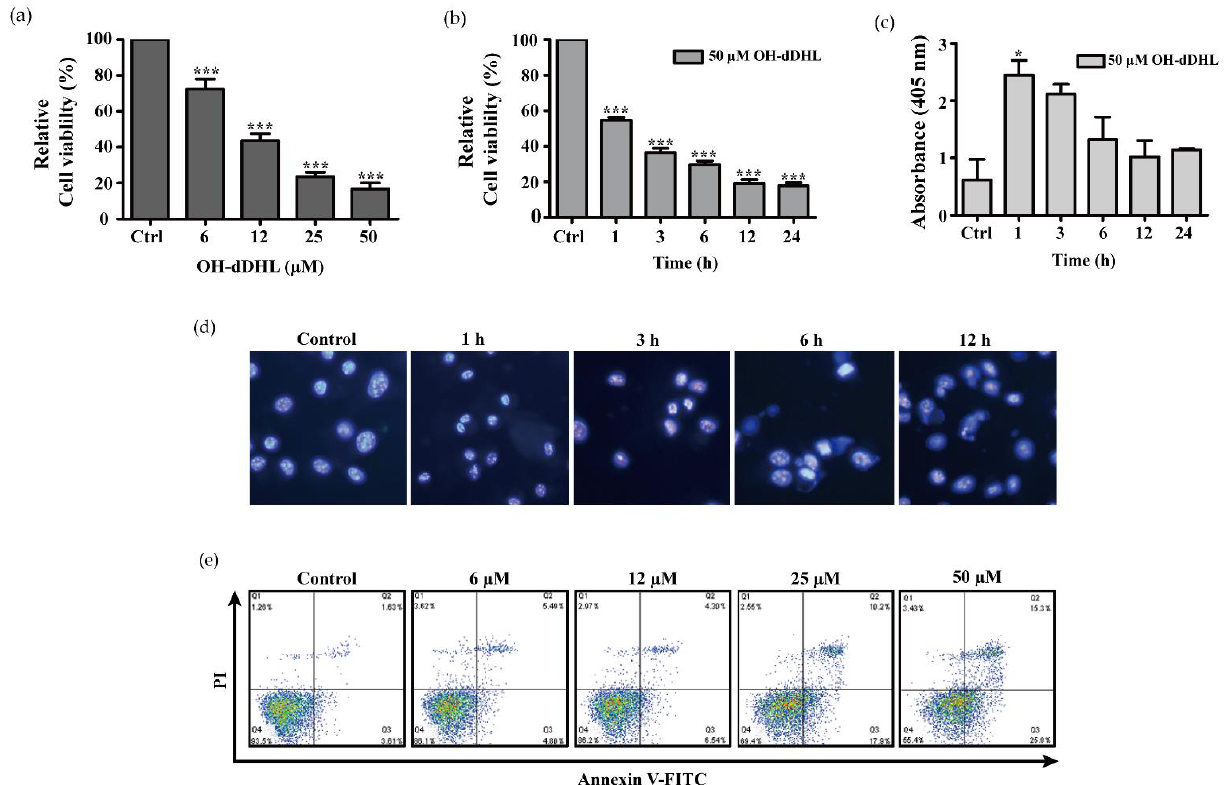
Figure 2. OH-dDHL-induced apoptosis in BMDMs. ( a , b ) Cell viability was determined using CCK assay. BMDMs were treated with OH-dDHL in a time- and dose-dependent manner for 24 h. ( c ) DNA fragmentation was analyzed using a Cell Death Detection ELISA kit in 50 µM OH-dDHL-treated BMDMs in a time-dependent manner. Data are presented as mean ± SEM of three independent experiments. ***, p < 0.001, *, p < 0.05 vs. control. ( d ) Apoptotic cells were stained with DAPI. Images were captured using a fluorescence microscope. Magnification: ×400. ( e ) Apoptotic population was stained with Annexin V/PI and detected using Flow cytometry.